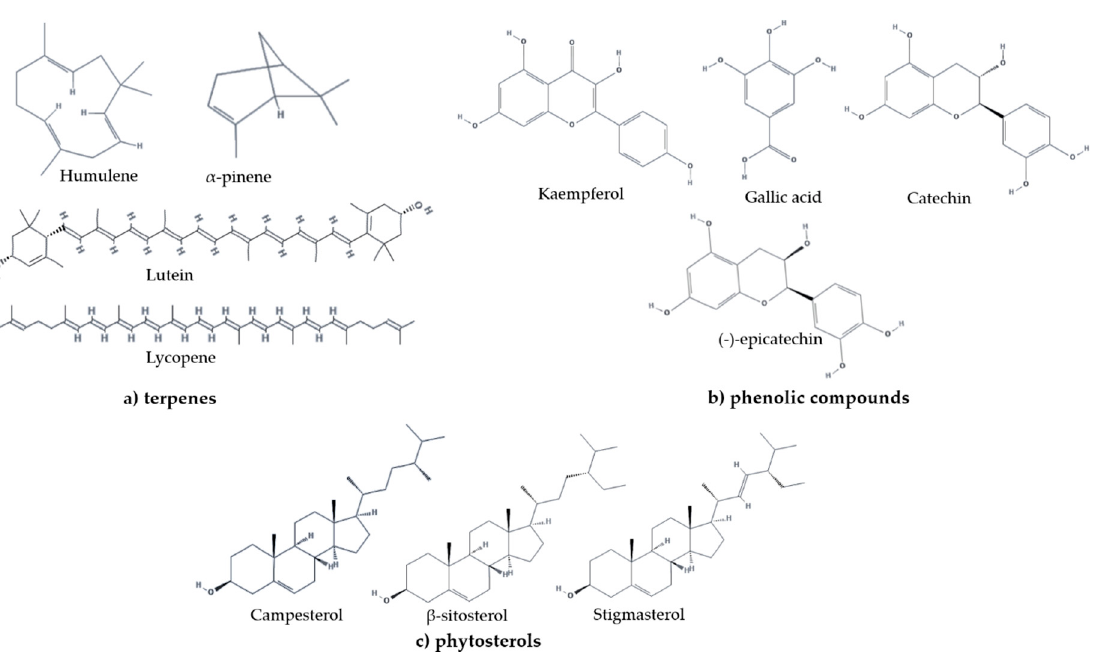
Figure 1. Chemical structure of ( a ) terpenes, ( b ) phenolic compounds, and ( c ) phytosterols. The structures Figure1. Chemicalstructureof( a )terpenes, ( b )phenoliccompounds, and( c )phytosterols. Thestructures were obtained from the PubChem database [42–52] . were obtained from the PubChem database [42–52]. Table 1. Classification of terpenes according to the isoprene number. Table 1. Classification of terpenes according to the isoprene number. Terpenes